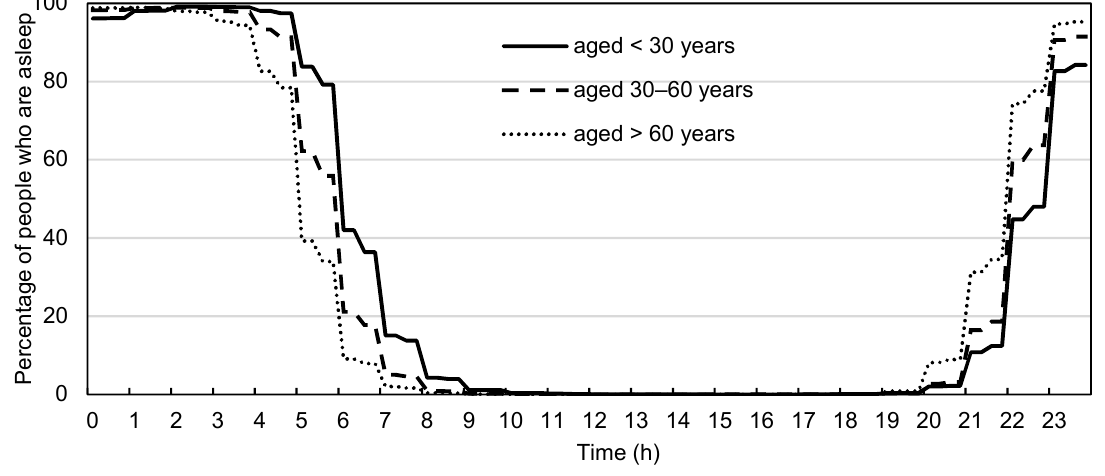
Figure 6. Age di ff erences in Vietnamese people’s sleeping temporal pattern by region (northern, central, Figure 6. Age differences in Vietnamese people’s sleeping temporal pattern by region (northern, Urban Sci. 2019 , 3 , x FOR PEER REVIEW and southern Vietnam) on weekdays. central, and southern Vietnam) on weekdays.